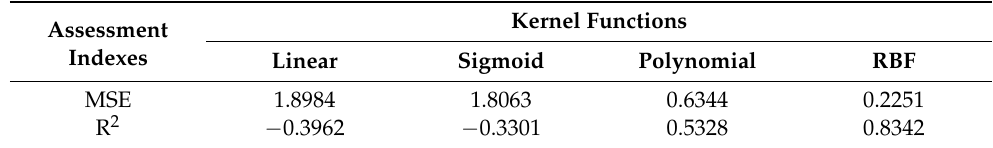
Table 6. Model performance with different kernel